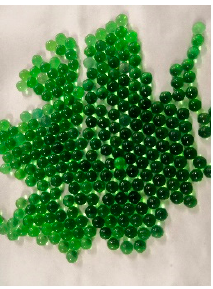
Figure 1. Glass beads used in the test.